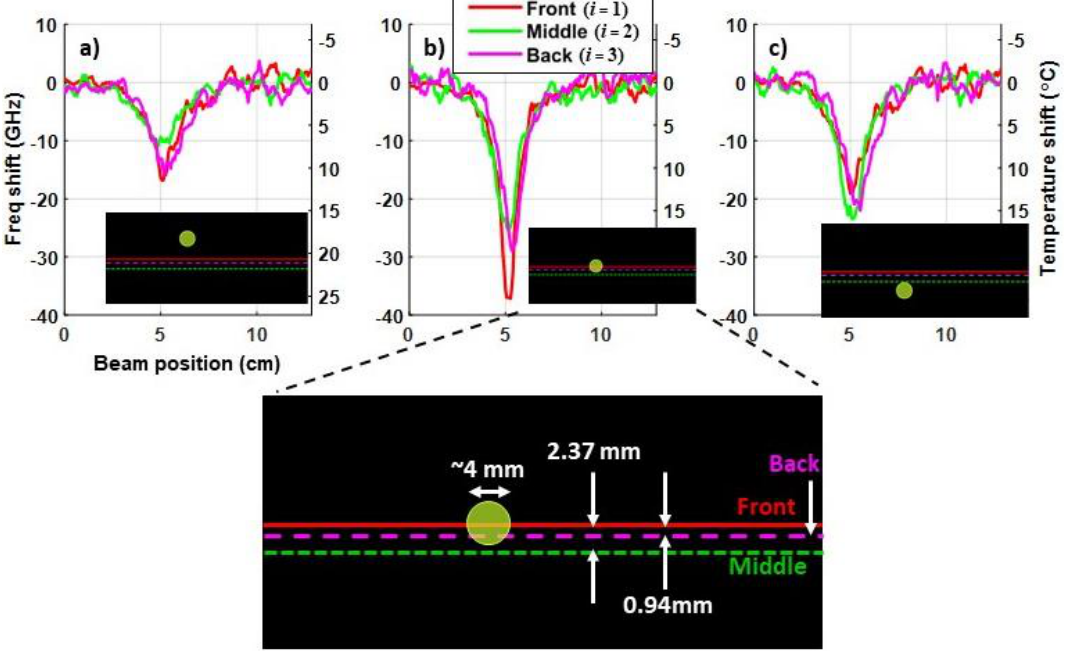
Figure 10. Examples of iterative measurements of frequency and temperature shifts when the ~4 mm laser beam was: ( a ) 5.27 mm above Segment 1 (front) of sensor; ( b ) aligned with Segment 1; and ( c ) 4.73 mm below Segment 1.